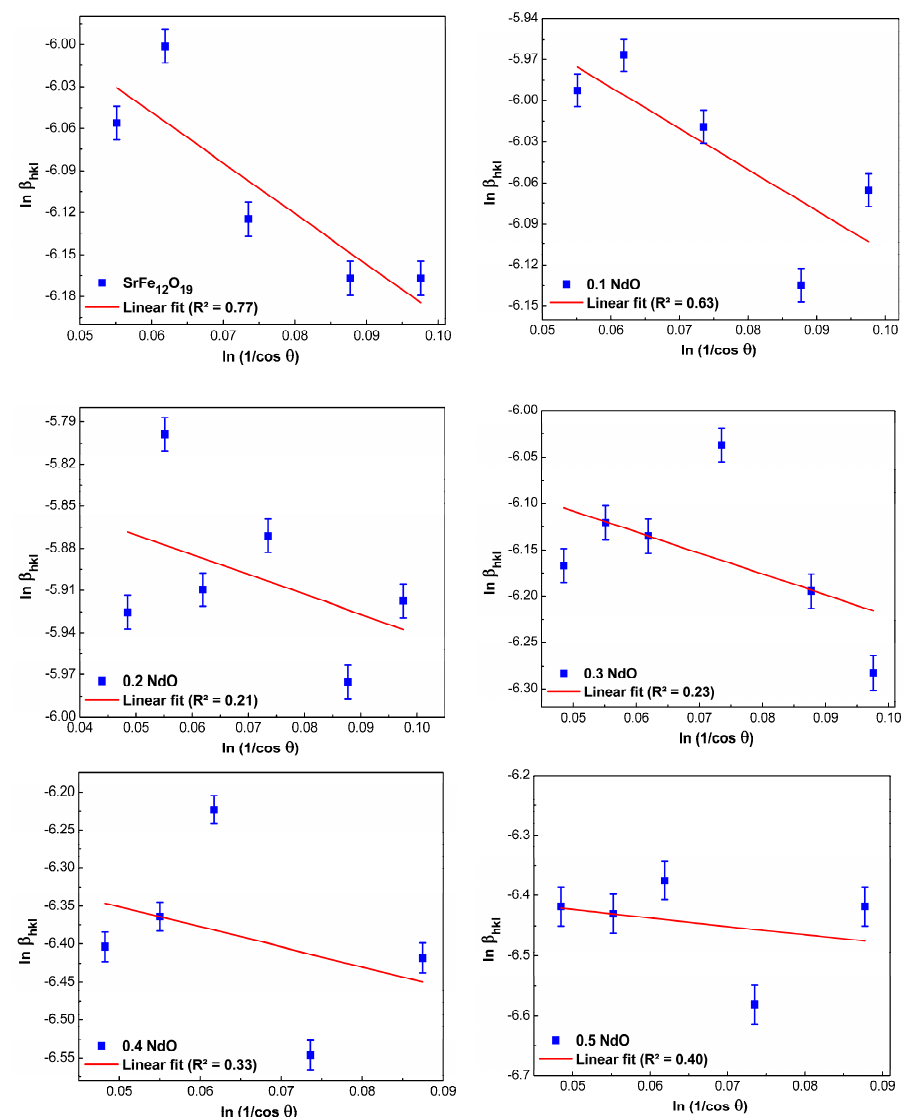
Figure 3. Scherrer plots for hexaferrite powders SrFe 12-x Nd x O 19 (0 ≤ x ≤ 0.5).